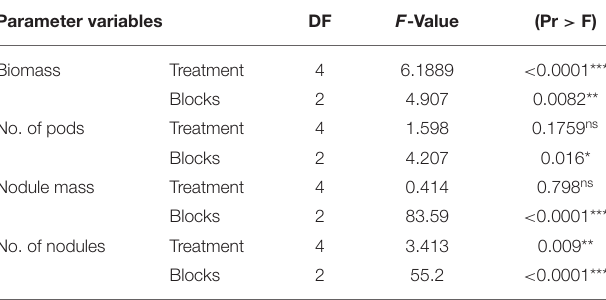
TABLE 1 | Summary ANOVA of mean response of treatment